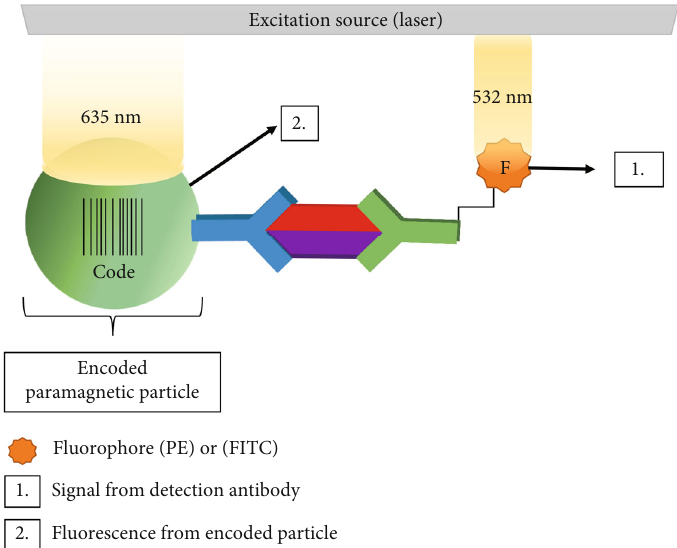
Figure 5: Biomarker detection using fl ow cytometry. The Luminex strategy detects multiplexed biomarkers using dual wavelengths. The two fl uorescent dyes are excited at a wavelength of 635nm, and the fl uorophore is excited at 532nm. The fl uorescent light emitted from the bead is detected at two separate wavelengths, corresponding to a speci fi c biomarker, while the signal produced from each fl uorophore is detected at another